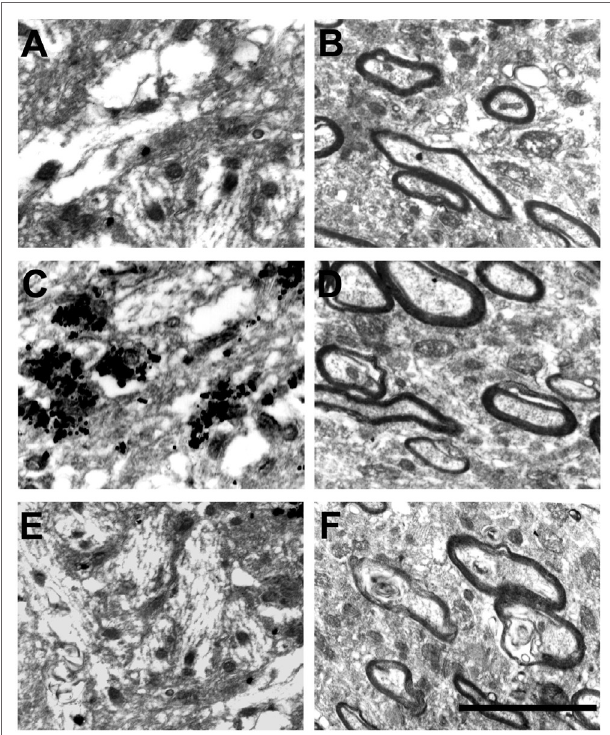
FigUre 2 | electron micrographs of the dentate gyrus molecular layer in controls (a,B), Pilo-treated (c,D) and chX + Pilo-treated animals (e,F) . (a,c,e) represent the inner molecular layer (IML). (B,D,F) represent the outer molecular layer (OML). Silver grain dots in the IML were only observed in Pilo-treated animals (c) . These profiles have not been found in the outer molecular layer of any of the groups (B,D,F) . Scale bar, 150